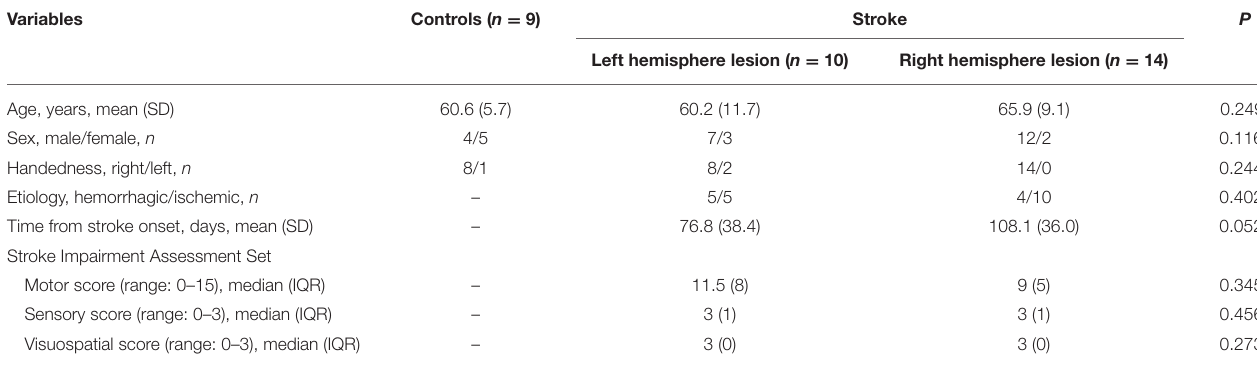
TABLE 2 | Summary of the characteristics of the controls and patients with stroke.